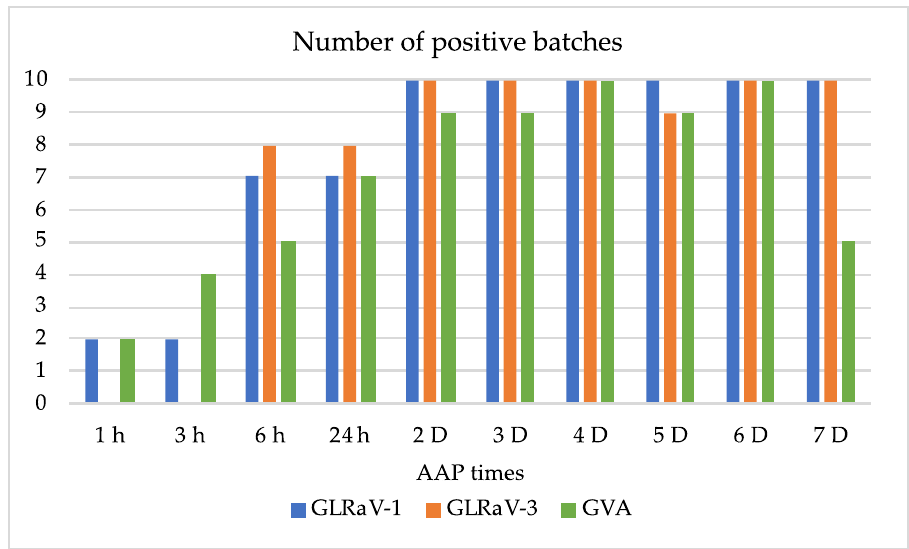
found to be negative following RT-PCR.